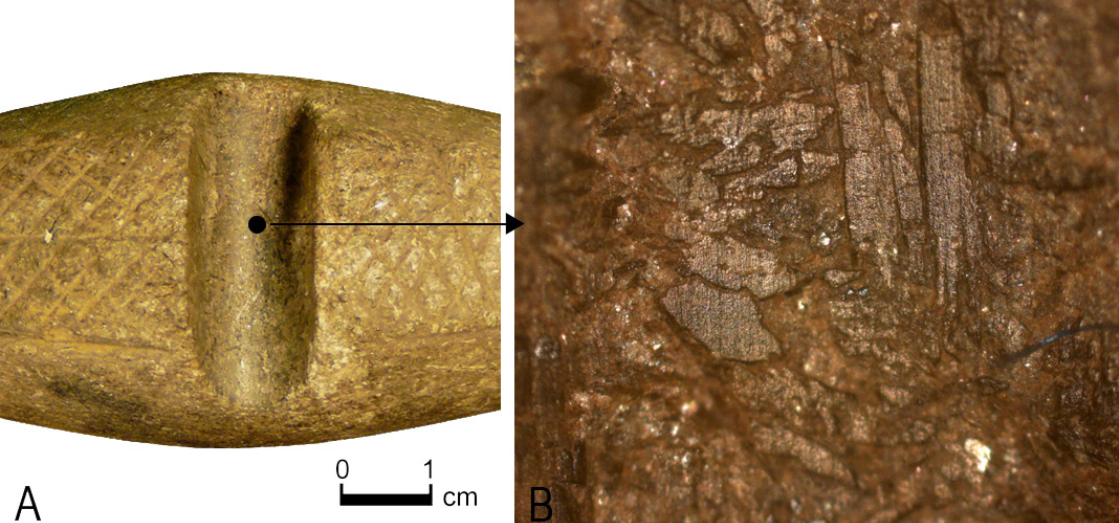
Figure 6. Kargopolie. A. Piece of the transverse grooved stone, B. microscopic use-wear traces in the groove (50x). (Photo by S.N.